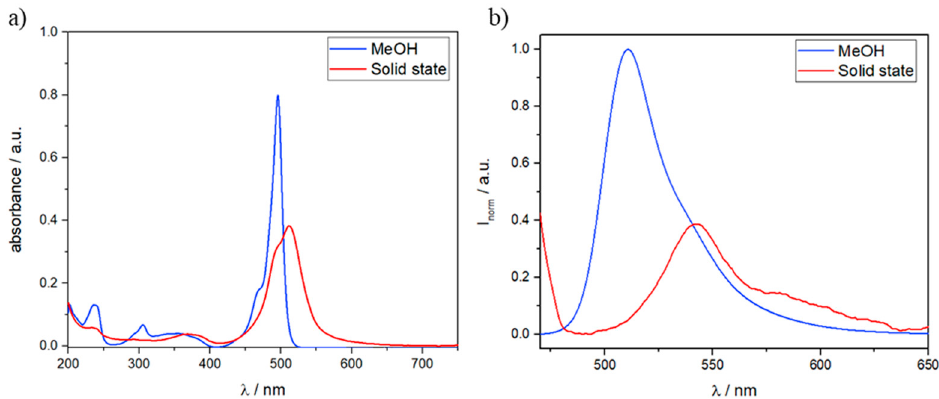
Figure 2. UV/Vis absorption ( a ) and emission ( b ) spectra of compound 1 in MeOH (c = 1 × 10 − 5 M) and in thin films from MeOH at 298 K ( λ exc = 450 nm).